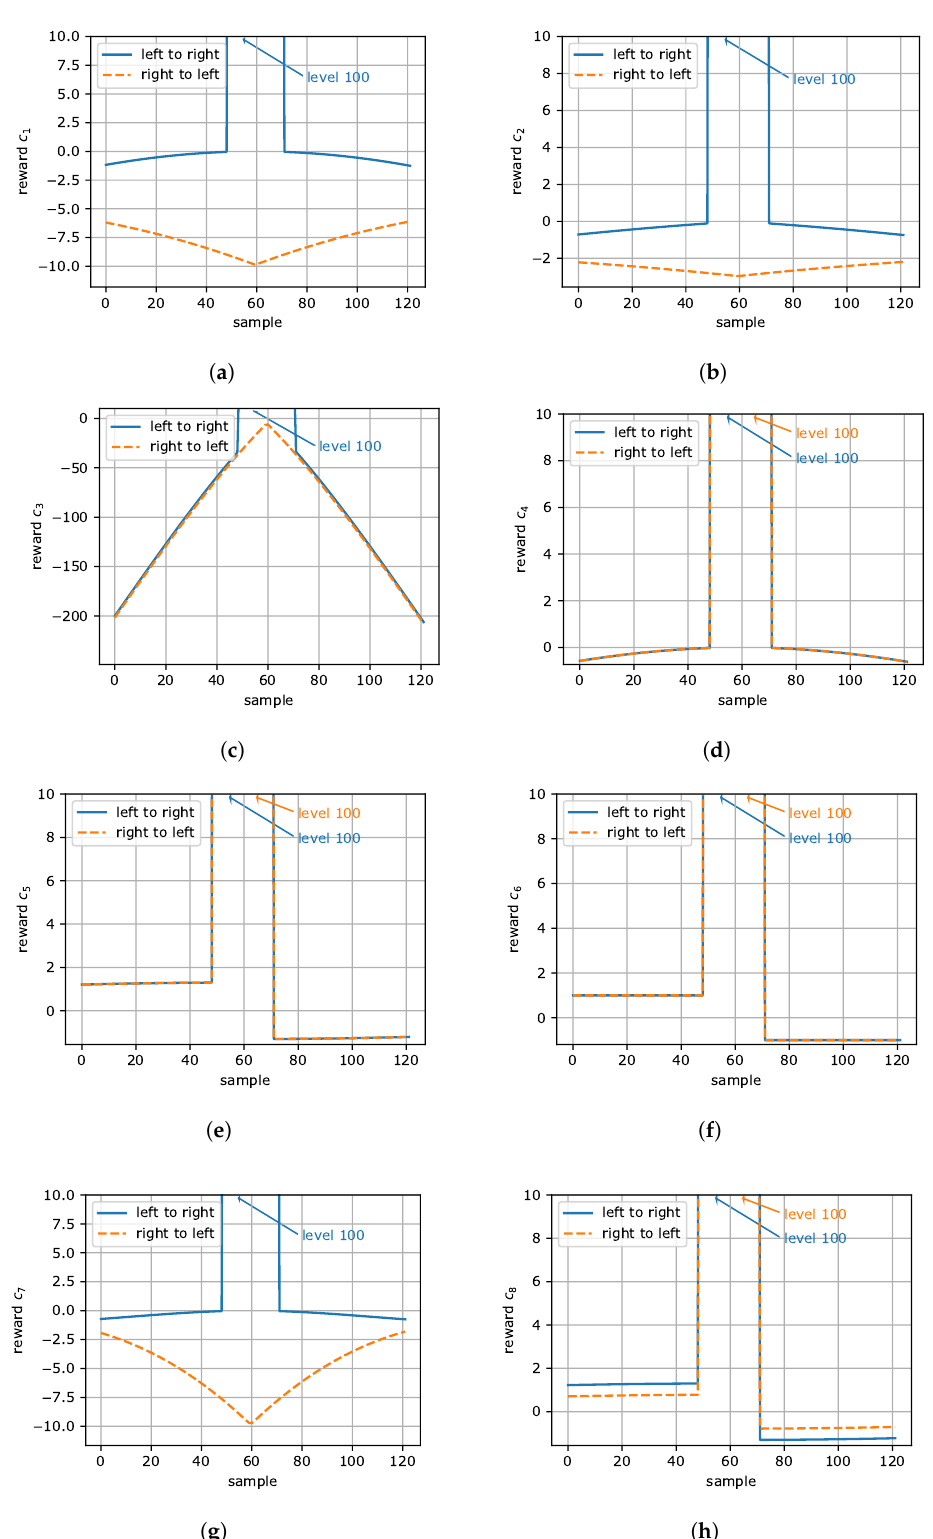
Figure 3. All rewards ( c 1 – c 8 ), respectively ( a – h ), presented, for example, movement of the mo- bile